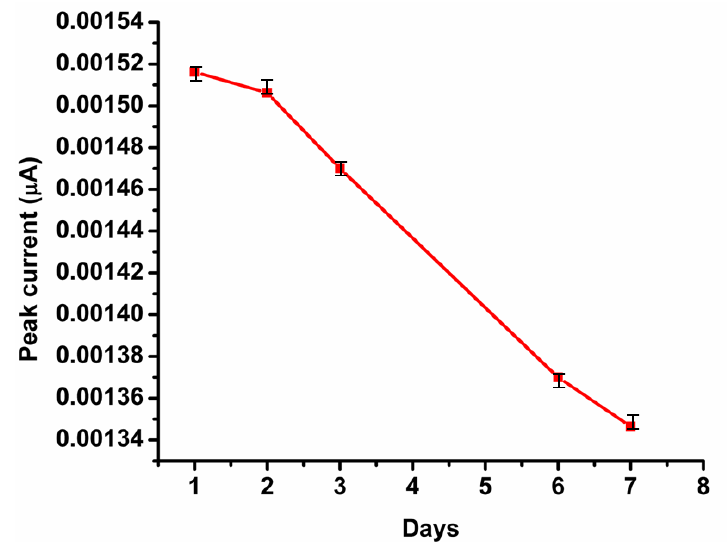
Figure 10. Stability of the TPP/AuNPs-S-Gr sensor for a period of 7 days.